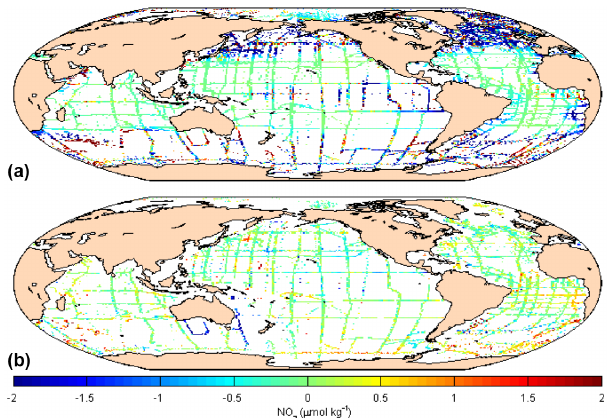
Figure 14. GLODAPv2.2016b nitrate gridded input data mi- nus WOA09 annual mapped nitrate climatology at 10m (a) and 3000m (b)